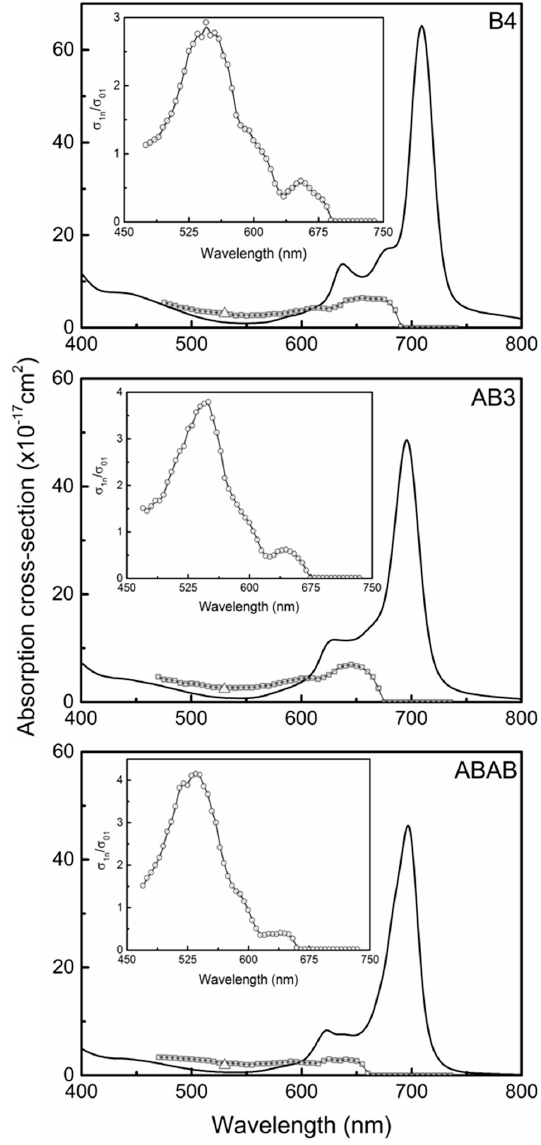
Figure 6. Ground (solid line) and excited state (open square) absorption cross-section spectra for B4 , AB3 and ABAB . The insets show the ratio (open circles) between the excited and ground state absorption cross-section. The open triangle represents the excited state absorption cross-section at 532 nm, obtained with the single-pulse Z-scan technique.